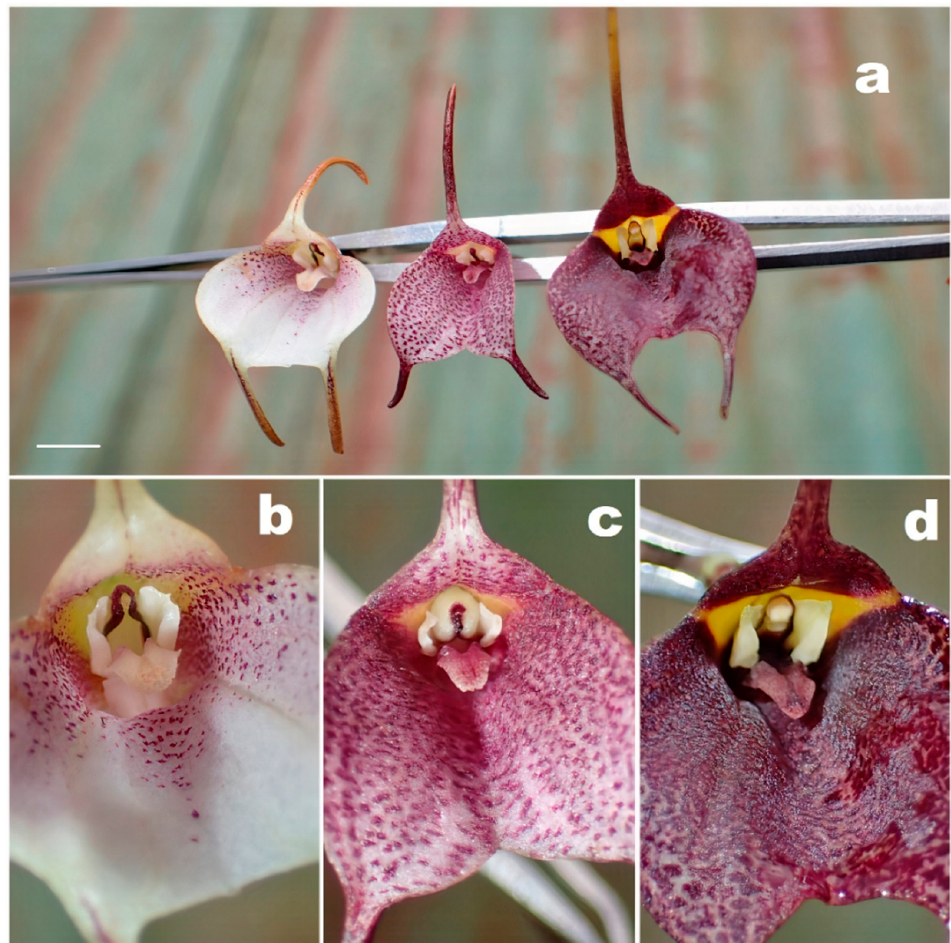
Figure 1. Flowers of the three Masdevallia species: ( a ) Comparison; ( b ) Masdvallia floribunda Lindl.; ( c ) Masdevallia × urbanae Archila, Lipi ń ska & Szlach; ( d ) M. tuerckheimii Ames (phot. Lipi ń ska, scale bar: 5 mm).